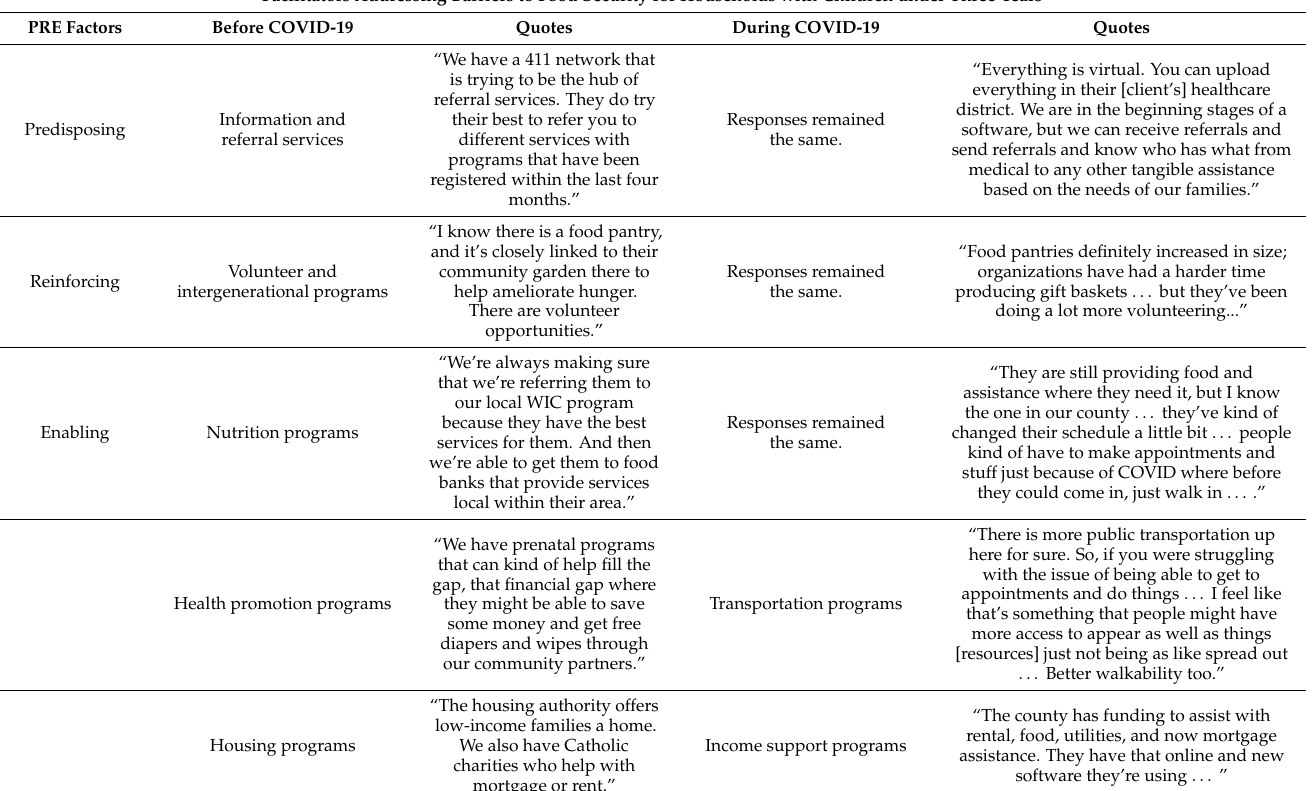
Table 3. Predisposing, Reinforcing, and Enabling (PRE) factors influencing the facilitators to obtain adequate, high-quality, and age-appropriate food for children under three in low-income communities before and during